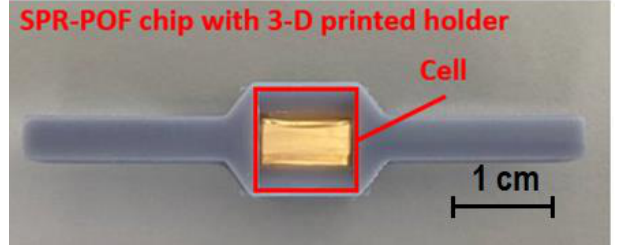
Figure 1. Picture of the SPR – POF chip bounded with the 3D-printed holder.